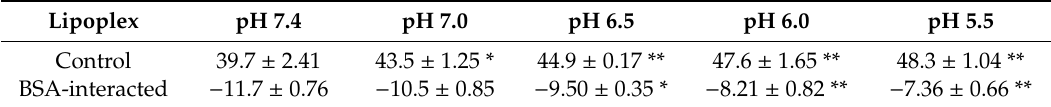
Table 2. Changes in zeta potential of lipoplex by